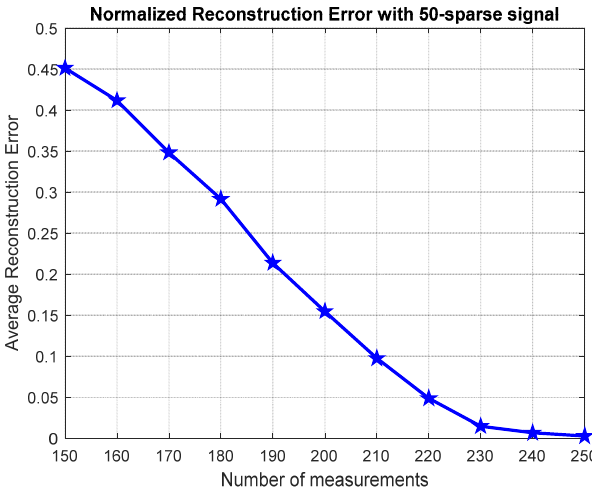
Figure 11. Reconstruction error in the recovery 50-sparse signal length 1000 based on small number of CS